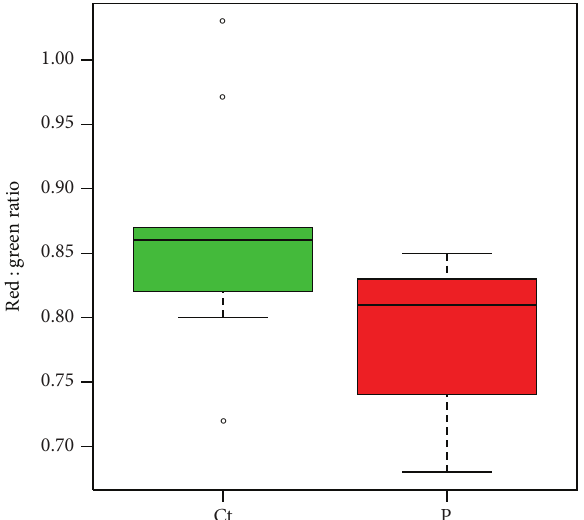
Figure 4: Relative Δ𝜓 𝑚 of patient-derived and control fibroblasts. Relative Δ𝜓 𝑚 was determined by JC-1 red :green fluorescent emission ratios for each fibroblast cell line in three experimental runs. Fibroblasts from P1 were not available; results pertain to a comparison of P2 and P3 parkin -mutant fibroblast with the three controls. Similar Δ𝜓 𝑚 was seen for patient-derived (P) and control (Ct) fibroblasts ( 𝑝 = 0.3285 ). ∘ , outlier; Δ𝜓 𝑚 , mitochondrial membrane potential.